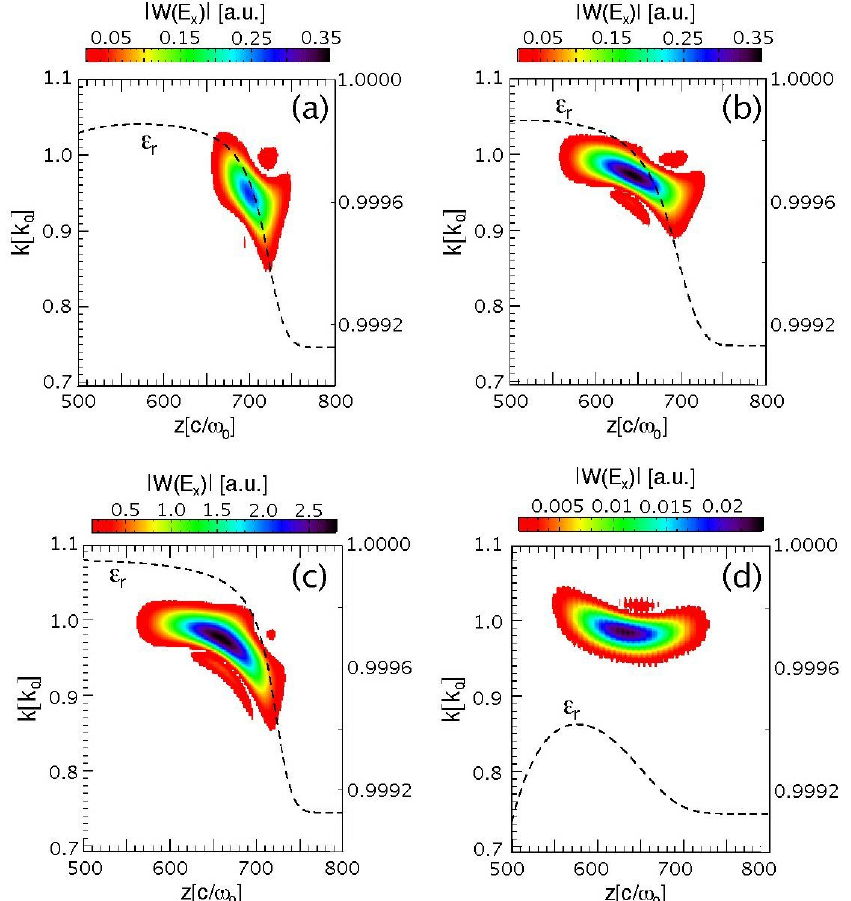
FIG. 2. (Color) Four plots depicting the Wigner transform of the x component of the laser electric field in the middle of the simulation (cid:4) z; k (cid:5) (cid:3) box and the relative permittivity as functions of z . The Wigner transform of a function ’ (cid:4) z (cid:5) is defined as [39] W ’ R 1 1 (cid:5) ’ (cid:13) (cid:4) z (cid:2) z 0 (cid:5) dz 0 and the relative permittivity valid under the quasistatic approximation is " (cid:3) (cid:4) 2 (cid:3) 1 (cid:2) n p e (cid:2) ikz 0 ’ (cid:4) z (cid:8) z 0 . r (cid:2)1 n c 2 2 1 (cid:8) In each plot, the vertical axis on the left corresponds to the local wave number over the initial laser wave number and the vertical axis . The four plots represent results from four different computer simulations after 0.18 cm of laser propagation into a on the right to " r (cid:3) 1 : 5 (cid:1) 10 18 cm (cid:2) 3 . (a) A 3D simulation of a 30 fs laser with a (cid:3) 4 and matched profile. (b) A 2D simulation of a plasma with n p 0 (cid:3) 4 and matched profile. (c) A 2D simulation of a 50 fs laser with a (cid:3) 10 and matched profile. (d) A 2D 50 fs laser with a 0 0 (cid:3) 1 . Plot (c) is typical for the ultrarelativistic blowout regime while plot (d) is typical for the linear simulation of a 50 fs laser with a 0 (cid:3) 4 , are more similar to the ultrarelativistic blowout regime. Plots (a) and (b), which result from simulations with a 0